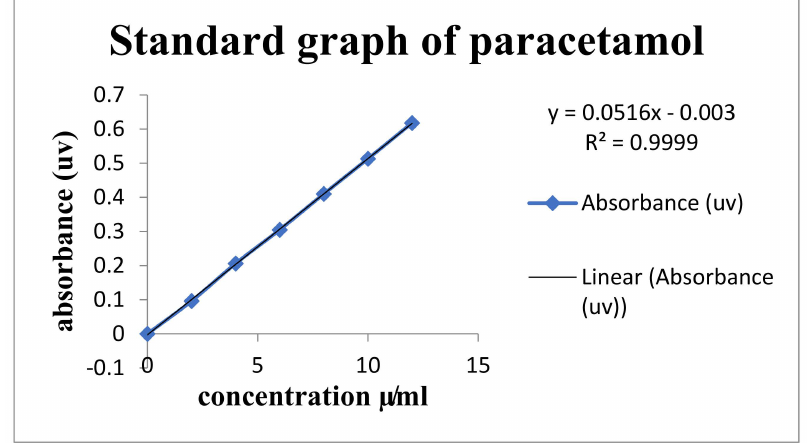
Figure 9. Standard graph of paracetamol drug.